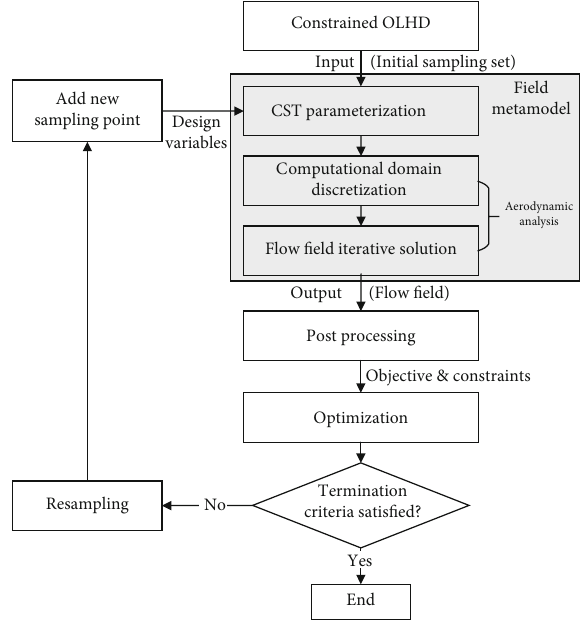
Figure 2: Frameworkofthe fi eldmetamodel-enhancedSAO